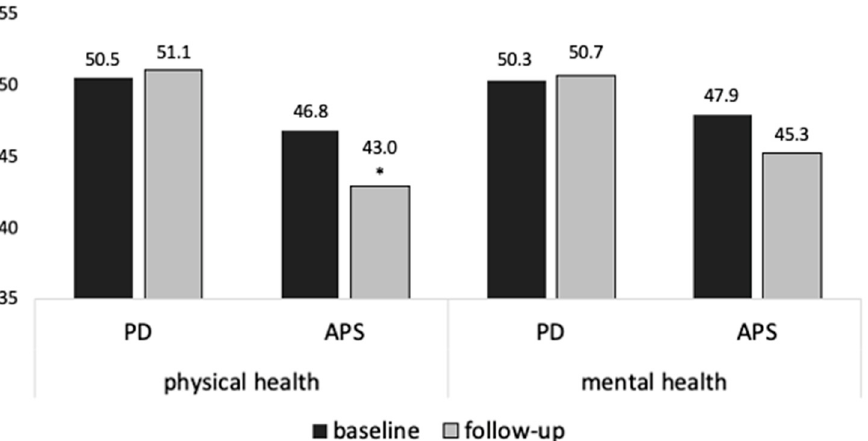
Figure 4. SF-12 summary scores of health-related quality of life at baseline and follow-up after 12 months (%). SF-12: Short-Form 12; *: p <